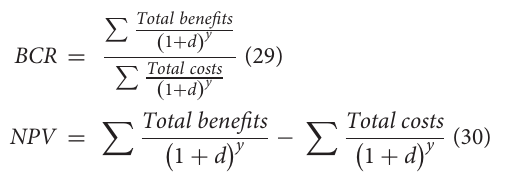
TABLE 6 | Overall discounted costs by different categories for establishing and maintaining a disease-free zone in Punjab province, Pakistan. Cost category Median (min, max) cost million PKR Percentage